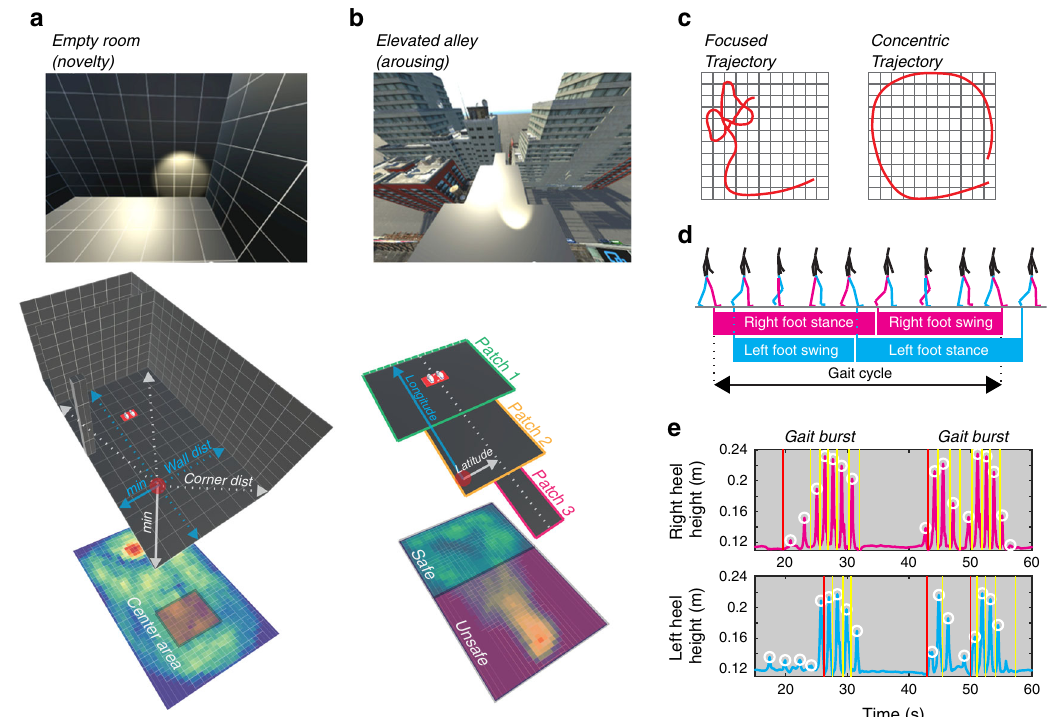
Fig. 1 Virtual reality scenarios designed to reveal behavioral variance in participants ’ locomotor responses under nonthreatening conditions. a Scenario 1: Empty room. Illustrations and example of key features feeding location parameters (e.g., distance to walls, corners, and center area) plotted on an average exploration heatmap. b Scenario 2: Elevated alley, consisting of successive narrower patches. Illustration and example of key features feeding location parameters, such as the threshold between patches to determine time to cross or time spent at each patch. c Examples of focused and concentric trajectories displayed in scenario 1 (adapted from ref. 101 ). d Example of the gait cycle and its subcomponents stance and swing. e Example of the detection of bursts of movement. Consecutive gait cycles, starting at the red line, separated by immobility